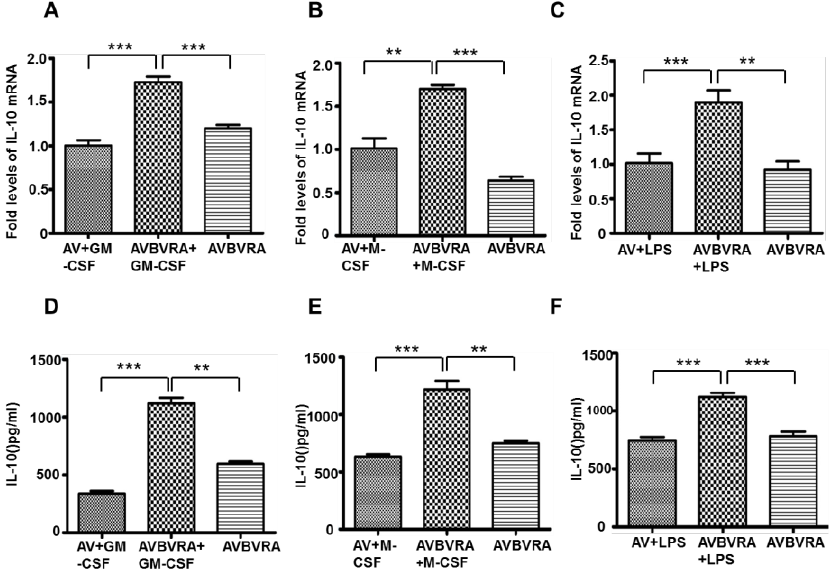
Figure 7. GM-CSF, M-CSF, or LPS increased IL-10 expression in BVRA positive macrophages. ( A ) IL-10 mRNA expression were detected by qRT-PCR in AV-BVRA macrophages stimulated with GM-CSF; ( B ) IL-10 mRNA expression were detected by qRT-PCR in AV-BVRA macrophages stimulated with M-CSF; ( C ) IL-10 mRNA expression were detected by qRT-PCR in AV-BVRA macrophages stimulated with LPS; ( D ) IL-10 protein expression were detected by ELISA in AV-BVRA macrophages stimulated with GM-CSF; ( E ) IL-10 protein expression were detected by ELISA in AV-BVRA macrophages stimulated with M-CSF; ( F ) IL-10 protein expression were detected by ELISA in AV-BVRA macrophages stimulated with LPS. n = 4, *** p < 0.001, ** p < 0.01. AVBVRA: macrophages transfected with AV-BVRA; AV+GM-CSF: macrophages transfected with AV-negative control virus and stimulated with GM-CSF; AVBVRA+GM-CSF: Macrophages transfected with AV-BVRA virus and stimulated with GM-CSF; AV+M-CSF: Macrophages transfected with AV-negative control virus and stimulated with M-CSF; AVBVRA+M-CSF: Macrophages transfected with AV-BVRA virus and stimulated with M-CSF; AV+LPS: Macrophages transfected with AV-negative control virus and stimulated with LPS; AVBVRA+LPS: Macrophages transfected with AV-BVRA virus and stimulated with